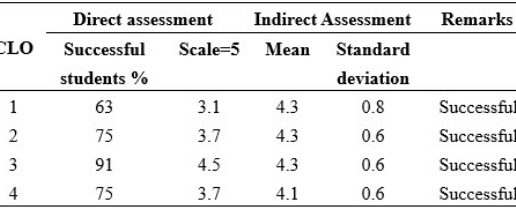
Table 6. CLO’s direct and indirect as-